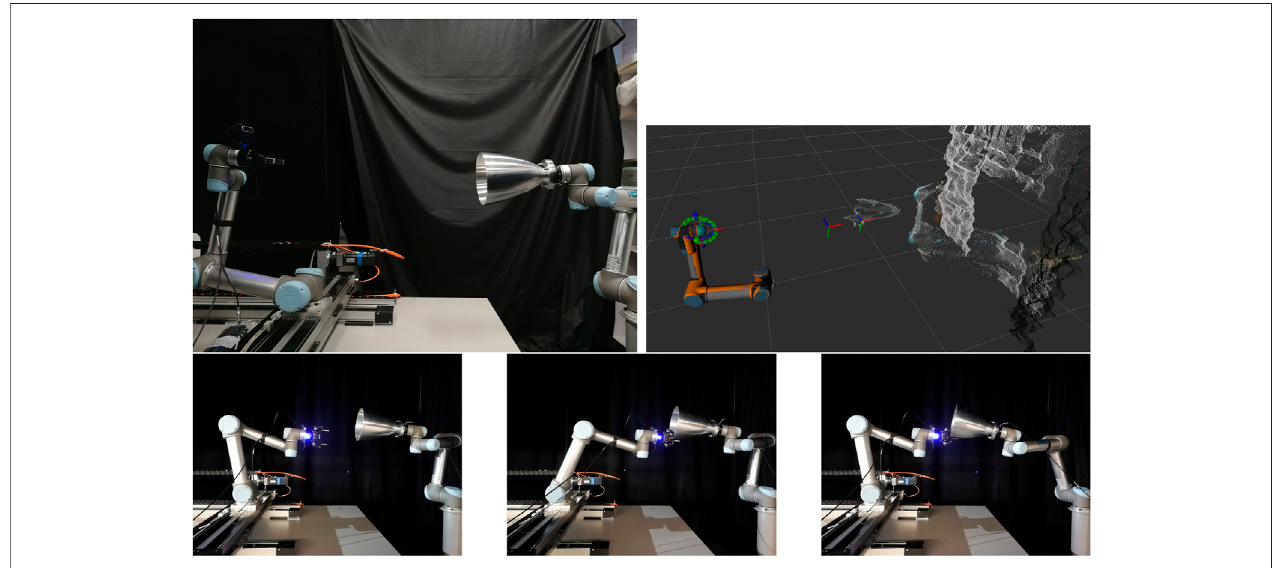
FIGURE 14 | Testbed setup (top left) and detected grasp and approaching pose on the nozzle point cloud (top right). Approaching pose (bottom left), grasping pose (bottom middle) and fi nal pulling pose (bottom right).